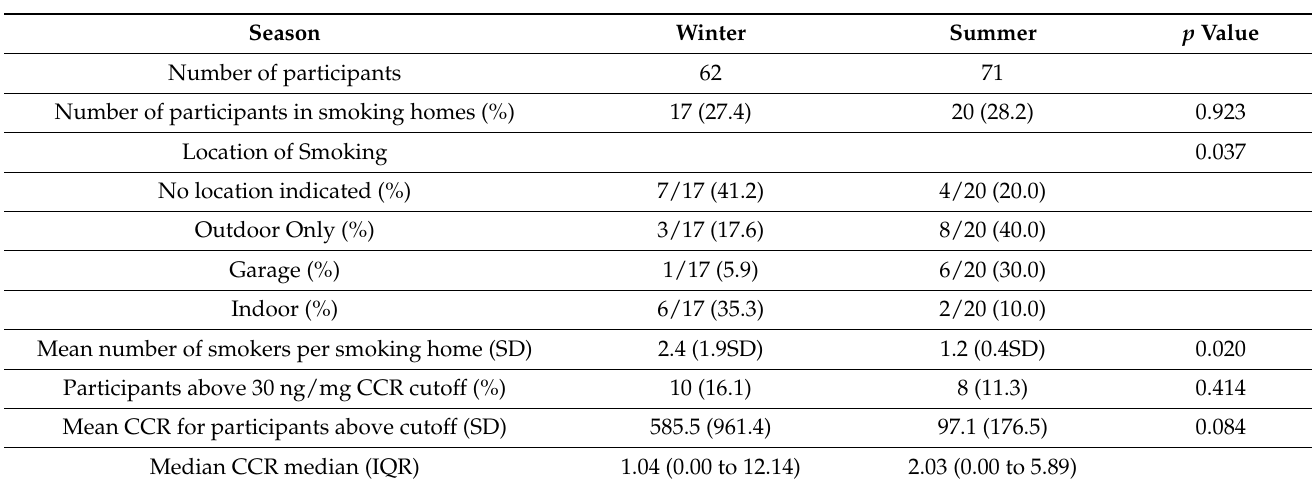
Table 3. Seasonality of smoking for participant dyads who completed questionnaires and provided a child urine